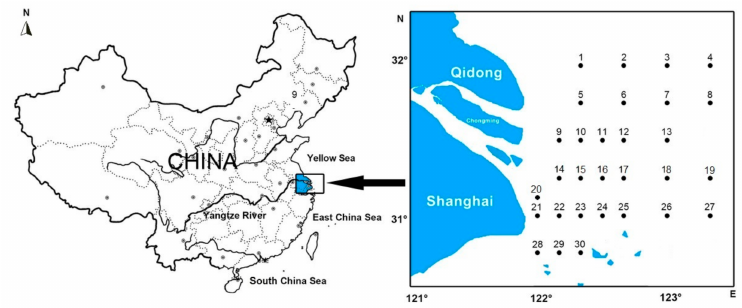
Figure 1. Sampling location (the specific station information of Yangtze Estuary was presented on the